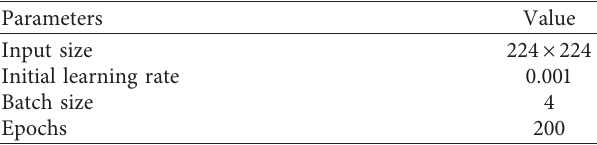
Table 3: Combination of